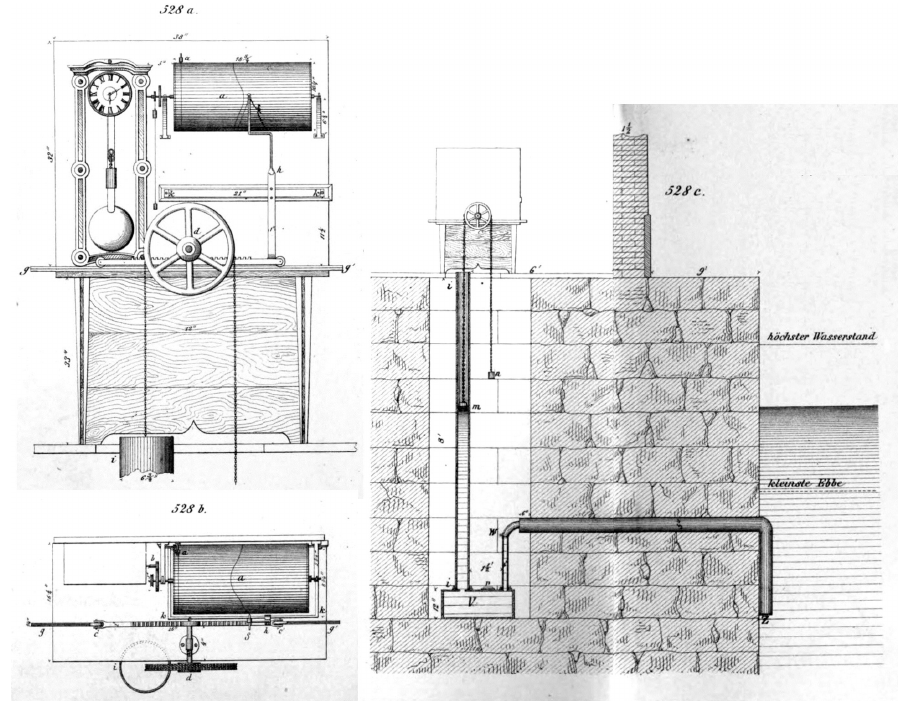
Figure 2. The tide gauge installed in 1859. View of the instrument from the front (528a) and from above (528b); vertical section of the north-western end of the building hosting the tide gauge and the stilling well (528c). Mean high and low waters are indicated by “höchster Wasserstand” and “kleinste Ebbe”, respectively. The figures are adapted from von Chiolich-Löwensberg (1865, 1866).